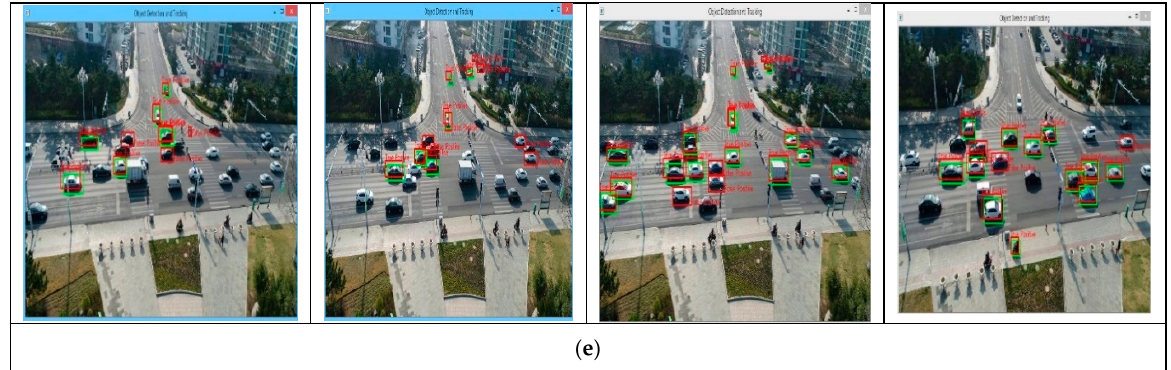
Figure 3. Five sequences of videos in different benchmarks. ( a ) M0204 sequence with quadruplet-based faster RCNN, ( b ) M0301 sequence with quadruplet-based faster RCNN, ( c ) M0704 sequence with quadruplet-based faster RCNN, ( d ) M1301 sequence with quadruplet-based faster RCNN, and ( e ) M1303 sequence with quadruplet-based faster RCNN .